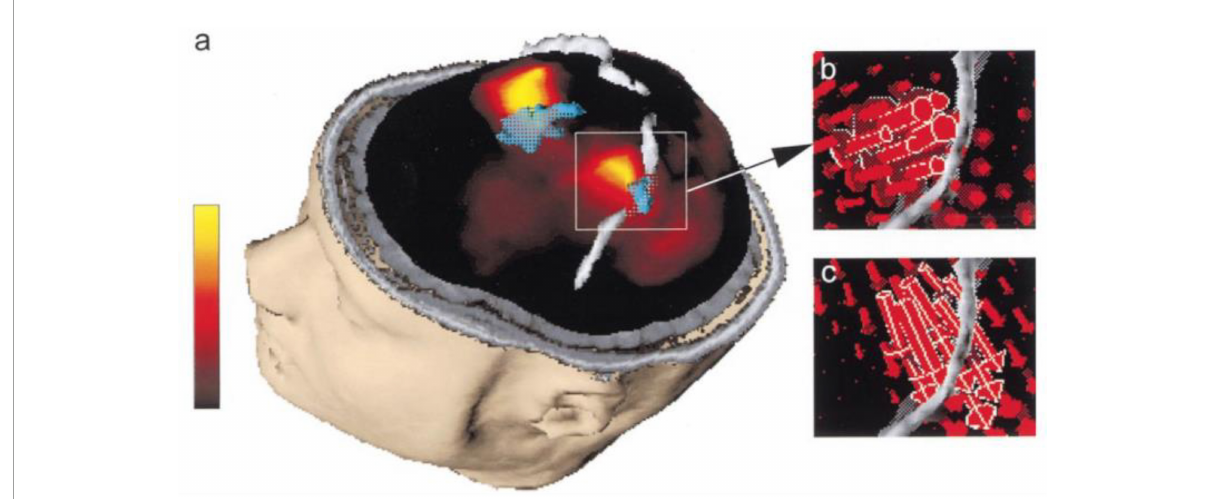
FIGURE4 “Primary sensorimotor area activation. (a) Rendering of the segmented head of subject 3, view from left and above. The segmented left and right central sulci are shown in gray. Current density map (maximum in yellow, minimum in black, linear scale shown on the left) at EMG onset is shown embedded in the section of the segmented head. fMRI-activated volume is shown in turquoise. The lateral maximum of cortical current density corresponds to the fMRI activation of the hand area of the left primary sensorimotor cortex and the medial current density maximum corresponds to the fMRI activation of the frontal medial wall motor areas. (b) Magnification of the hand area of the left primary sensorimotor area as shown in (a) . The individual current vectors of the CCD source are displayed, whereas in the current density map in (a) only the absolute values of the currents are visualized. In their sum they are equivalent to the current density source at EMG onset shown in (a) . The currents point in an anterior direction, consistent with activation of MI in the anterior bank of the central sulcus (Kristeva-Feige et al., 1994). (c) Current vectors in the same area as in (b) are shown 70 ms after EMG onset. The currents point in a posterior direction, consistent with activation of SI in the posterior bank of the central sulcus (Kristeva-Feige et al., 1994).”(Ball et al., 1999)—reprinted from (Kristeva-Feige et al., 1994) with permission.